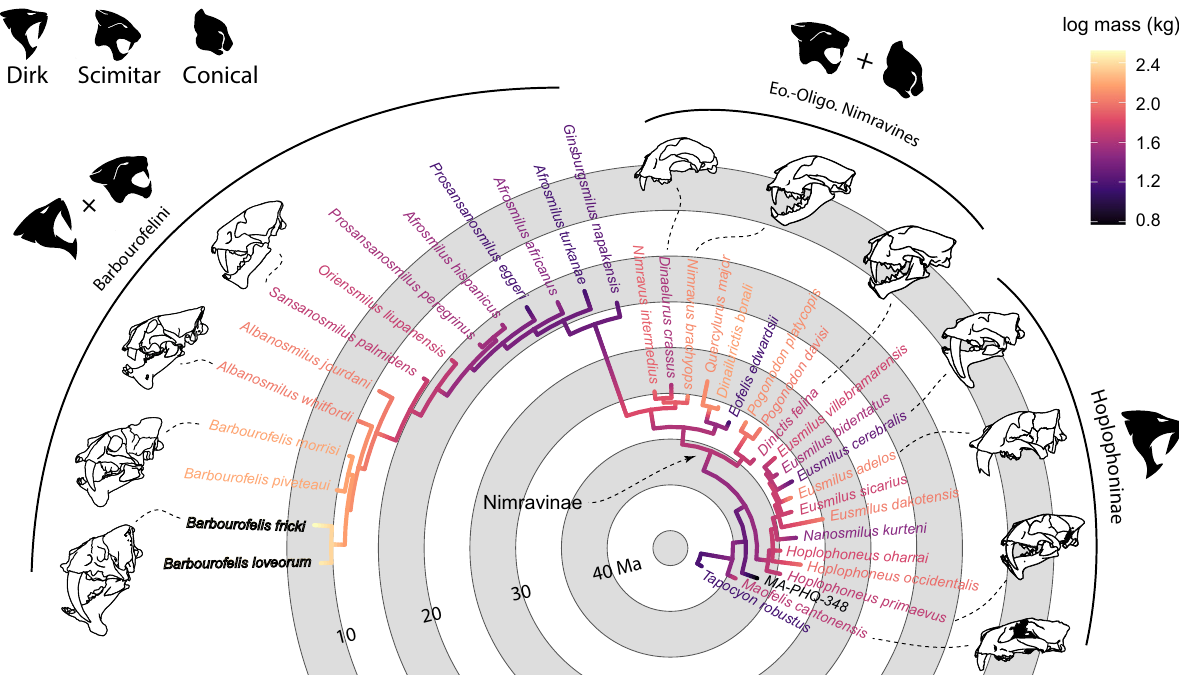
Figure 4. Tip-dated Bayesian phylogeny of the Nimravidae, outgroups (save Tapocyon ) removed. Two main clades were recovered, the Hopliphoninae and Nimravinae, the latter of which includes all barbourofelin taxa. Color gradient reflects maximum-likelihood estimation of ancestral body mass. Additional nodal values (e.g., posterior probability, divergence dates) can be found in Supplementary Fig.